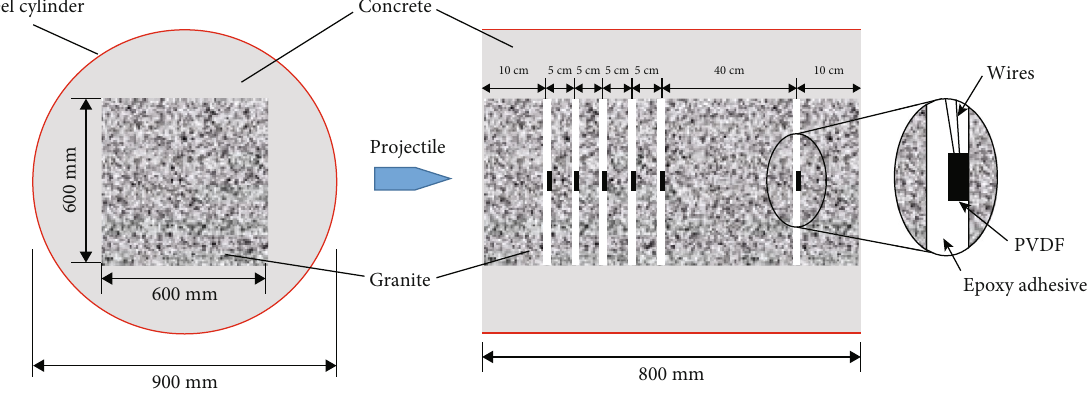
Figure 8: Diagram of targets.